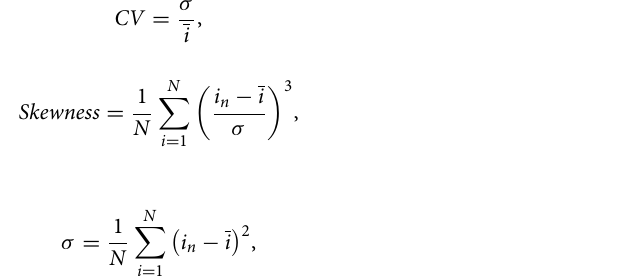
Figure 9. Effects of noise on evaluations of cytoskeleton bundling in synthetic images and actual CLSM images. ( A ) Original and synthetic images of virtual cytoskeleton bundling with random Gaussian noise. Random Gaussian noise [average intensity = 28, standard deviation (SD) = 32–160] was added to the images with 5% and 20% bundled filaments. ( B ) Scatter plot between skewness and CV. ( C ) Scatter plot showing the sensitivity of the skewness and CV methods in the detection of bundles in synthetic images with added noise. P values between the images with 5% and 20% bundled filaments were determined using the Mann–Whitney U-test. The broken line indicates the significance level ( P = 0.01). ( D ) Original and confocal laser scanning microscopy (CLSM) images of GFP-ABD2-labeled actin filaments in hypocotyl cells of A. thaliana plants. The image intensity was first normalized (average intensity = 0, standard deviation (SD) = 1), then Gaussian noise (average intensity = 0, SD = 1–5) was added to the actin filaments treated with DMSO (control images) and 20 μM TIBA (treatment images). Before measuring the skewness and CV, the images were skeletonized. ( E ) Scatter plot between skewness and CV. ( F ) Scatter plot showing the sensitivity of the skewness and CV methods in the detection of